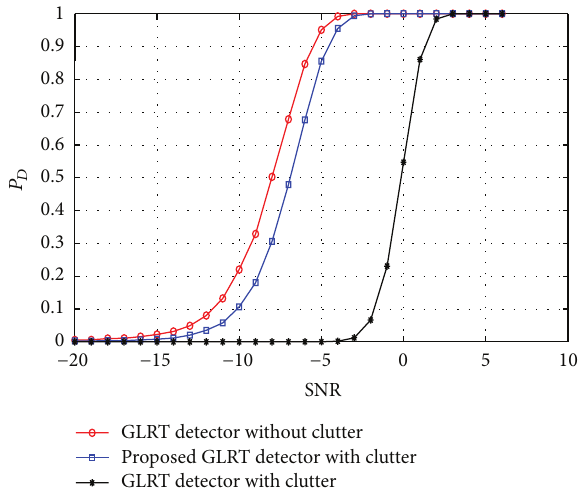
Figure 2: 𝑃 𝐷 comparison of a conventional GLRT detector and the proposed GLRT detector in the presence of